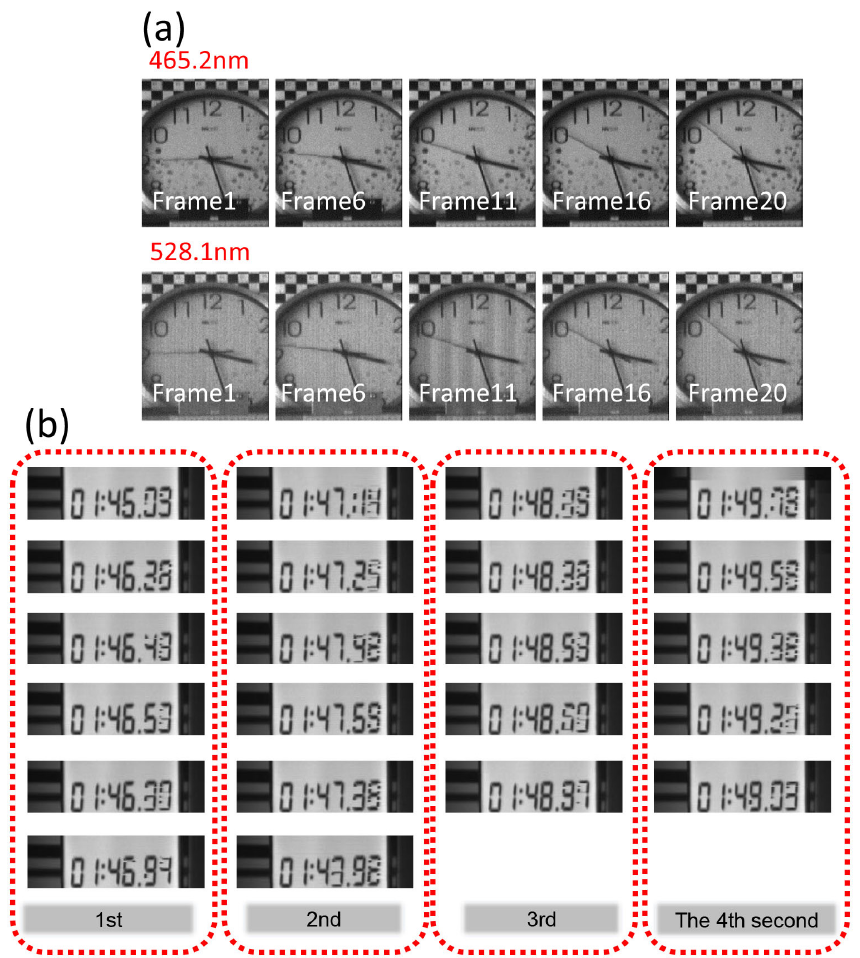
Figure 8. Spectral video results. ( a ) Imaging results for the clocks, including two wavebands with central wavelengths of 465.2 nm and 528.1 nm. ( b ) Imaging results for the timers with a total length of 4 s and 5 or 6 frames per second. We chose band 16 (central wavelength: 522 nm) for display.